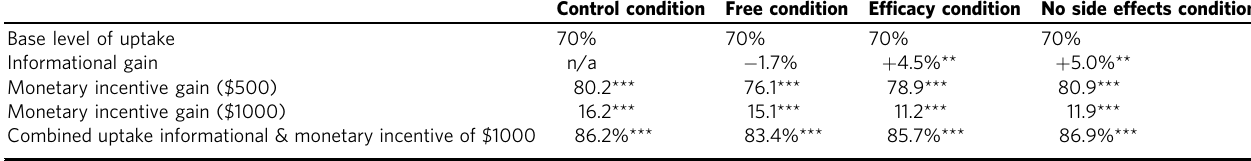
Table 5 Informational and monetary uptake gains by